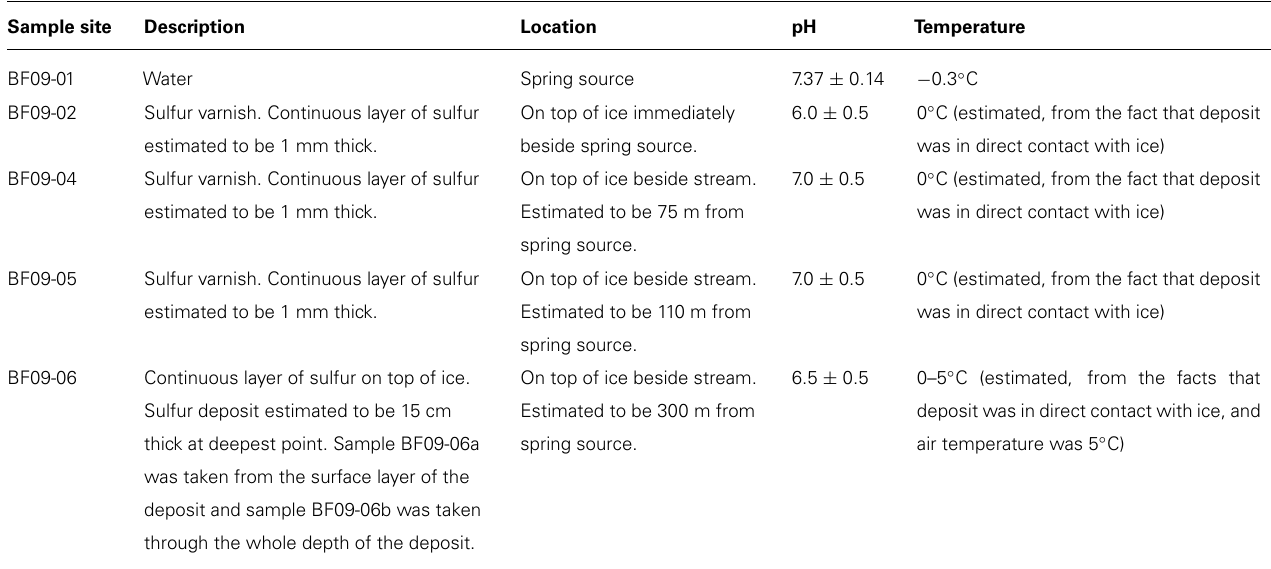
Table 1 | Location of sample sites and description of